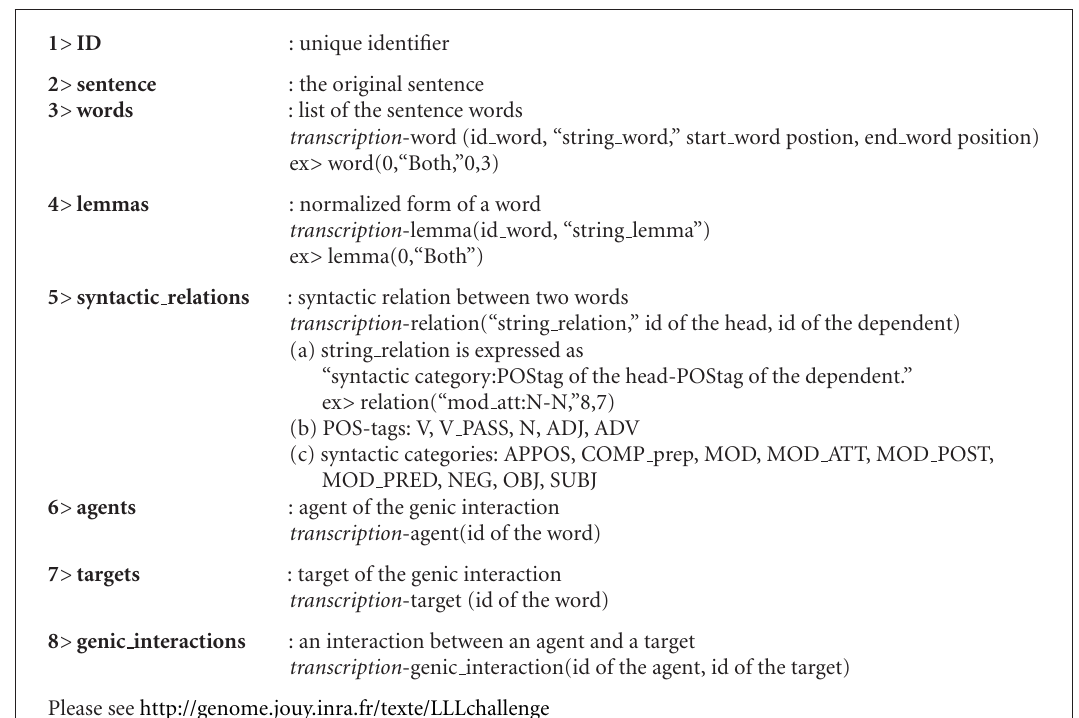
Algorithm 2: Detailed contents of LLL05 training